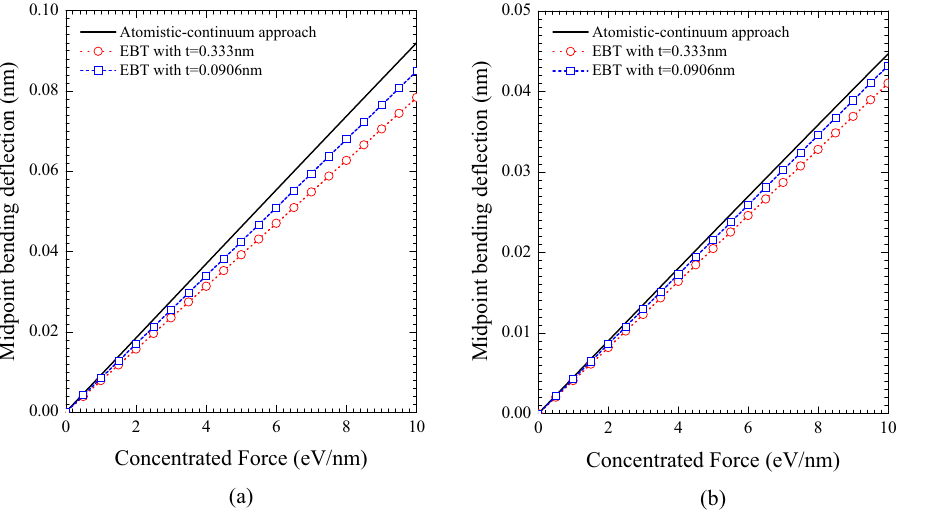
Figure 6: The midpoint bending de fl ection of 12 nm long ( 8, 8 ) ( a ) and ( 10, 10 ) ( b ) BNNTs with clamped constraint versus external lateral